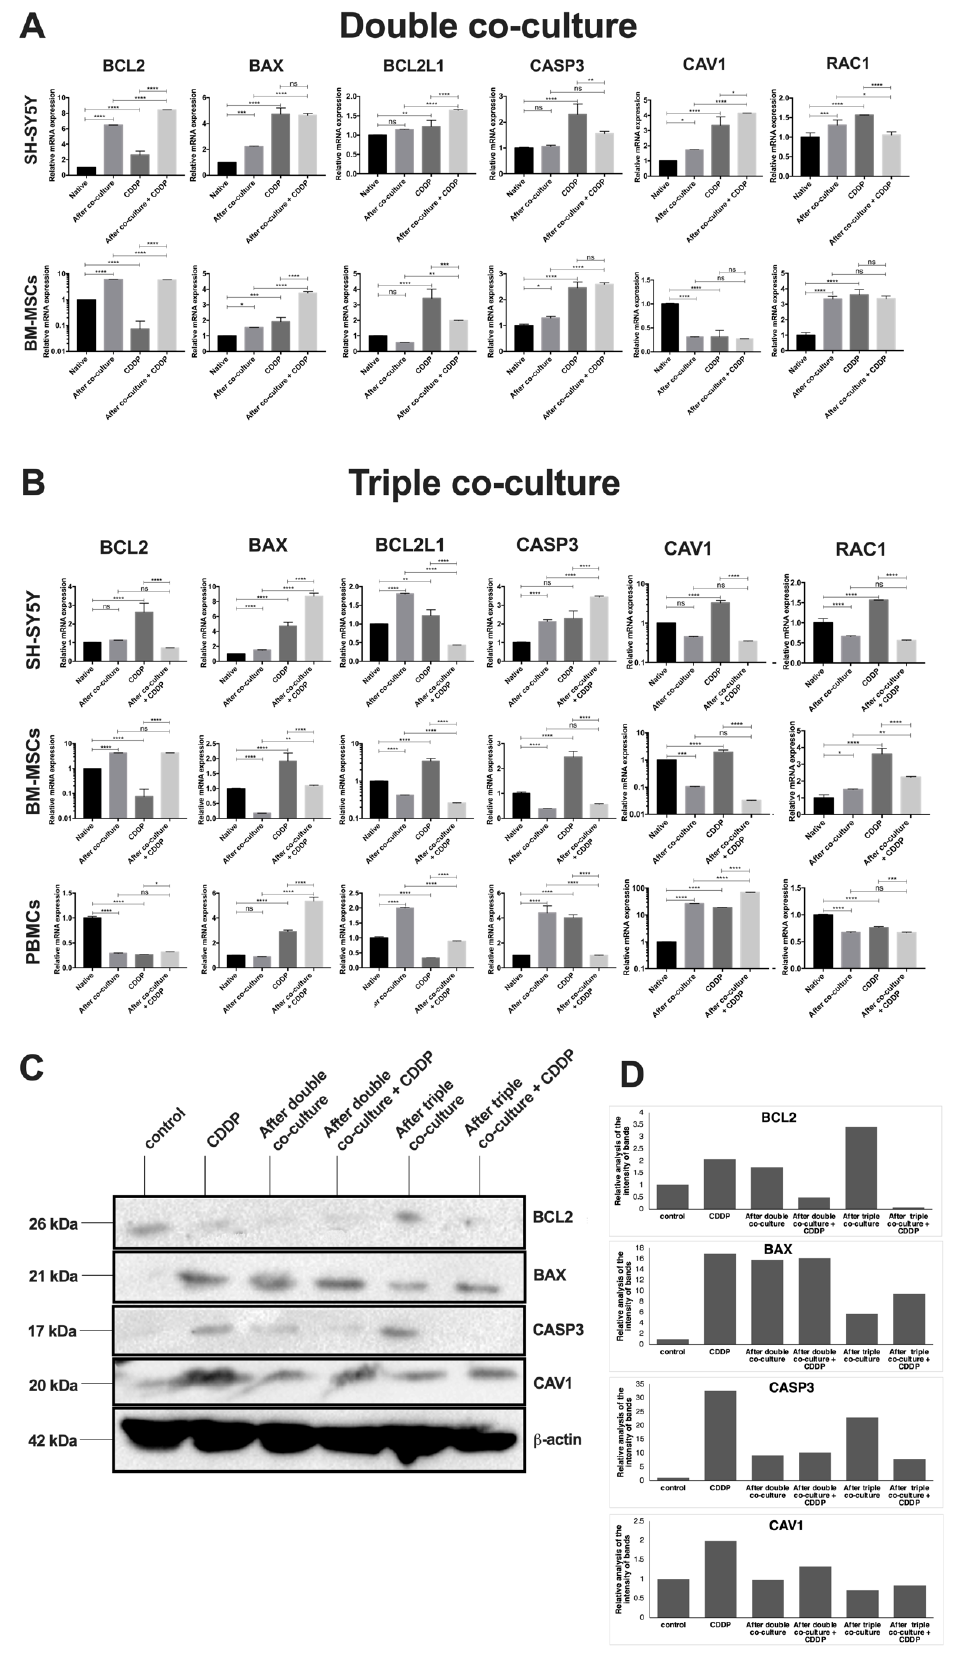
Figure 8. Analysis of the relative mRNA expression of BCL2, BAX, BCL2L1, CASP3, CAV1, and RAC1 genes in BM-MSCs, SH-SY5Y cells, and PBMCs after 72 h of incubation with CDDP at a